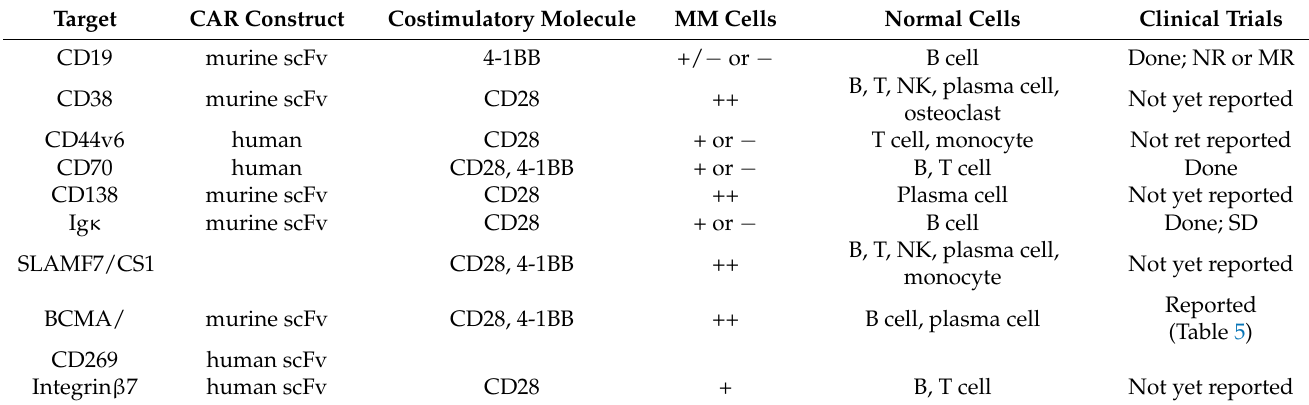
Table 4. Novel targets in chimeric antigen receptor (CAR)-T cell therapy in